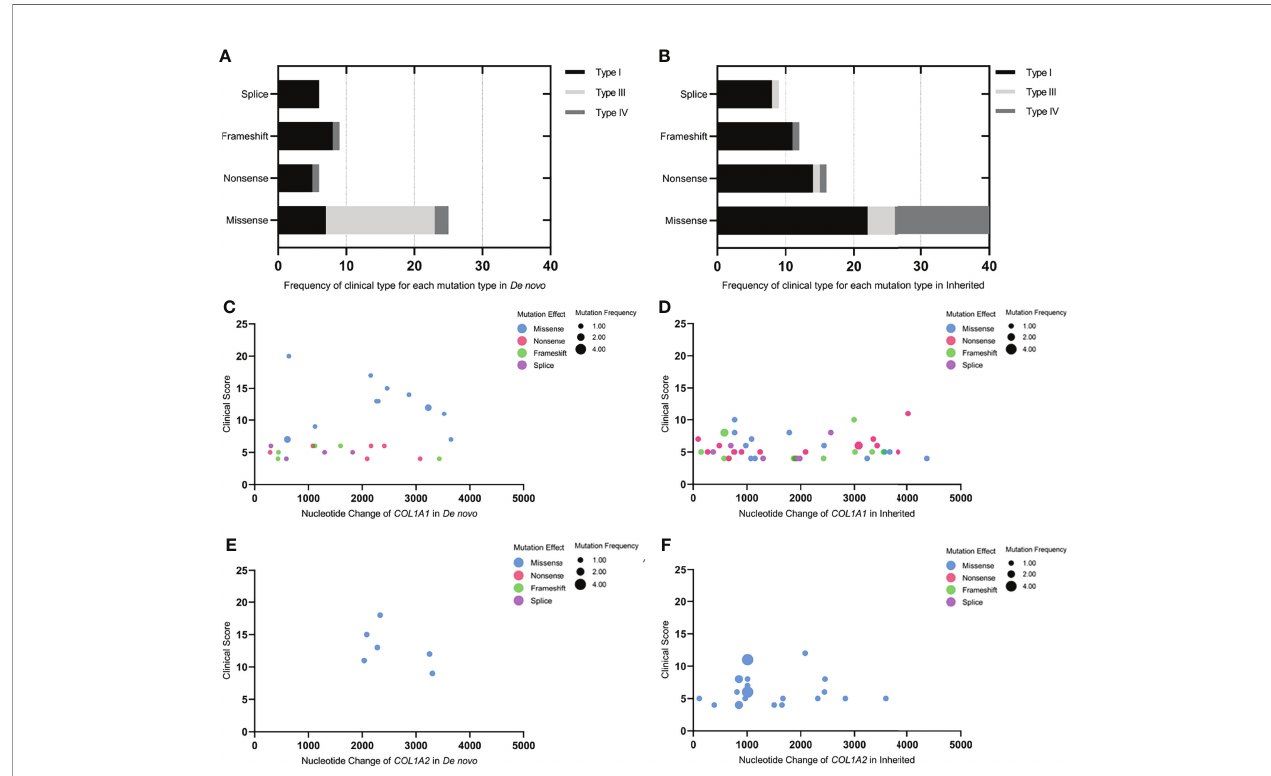
FIGURE 3 | Genotype-phenotype correlations in de novo and inherited mutations. (A, B) Frequency of clinical type for each mutation type in De novo and Inherited. (C – F) The bubble plots of the clinical score of available probands with de novo or inherited COL1A1/COL1A2 mutations. X-axis represented the mutation site on the COL1A1/COL1A2 gene; Y-axis was the clinical score; the colors of the bubble represented different mutation effects (missense, nonsense, frameshift, and splice, respectively); the size of the bubble indicated the mutation frequency of each mutation site in the de novo or inherited mutation group. The bubble was higher and bigger; the phenotype was more severe, and the mutation site was more